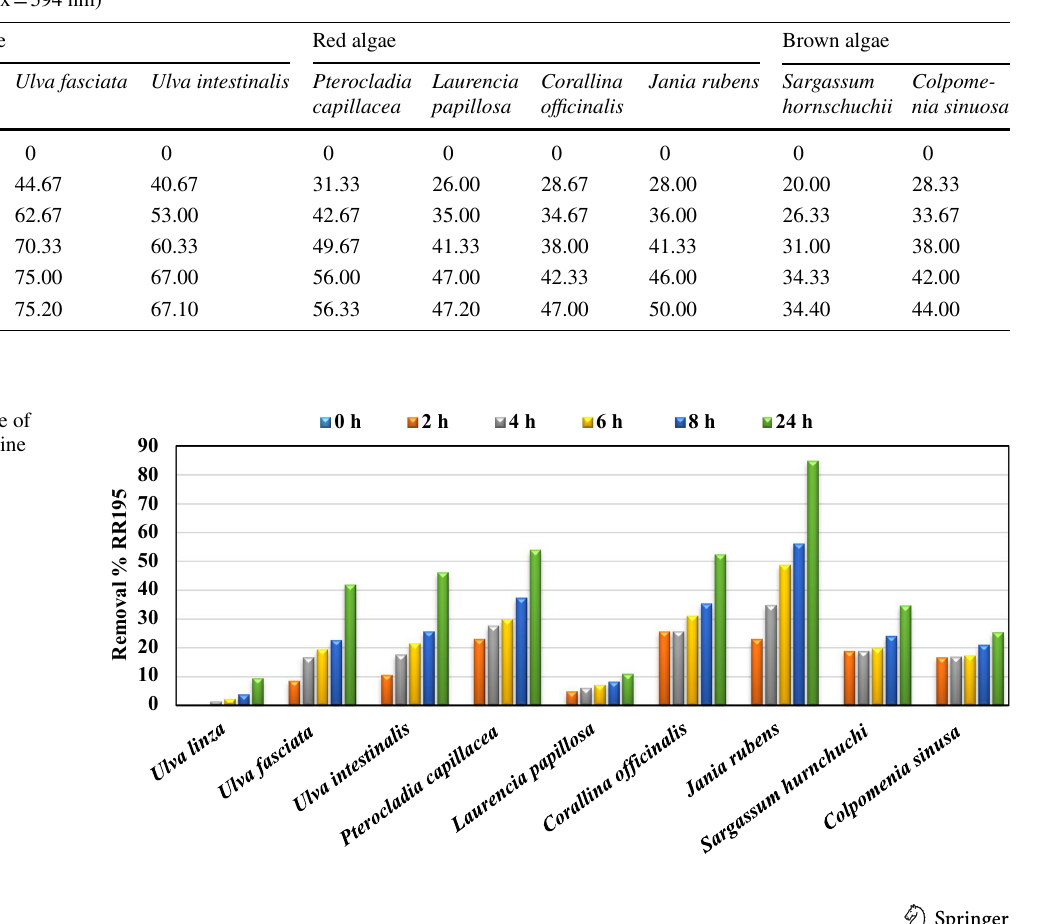
Table 5 Removal percentage of Reactive Blue 19 (RB19) by the nine studied dried algal species Removal % of RB19 (λmax = 594 nm) Algae Green